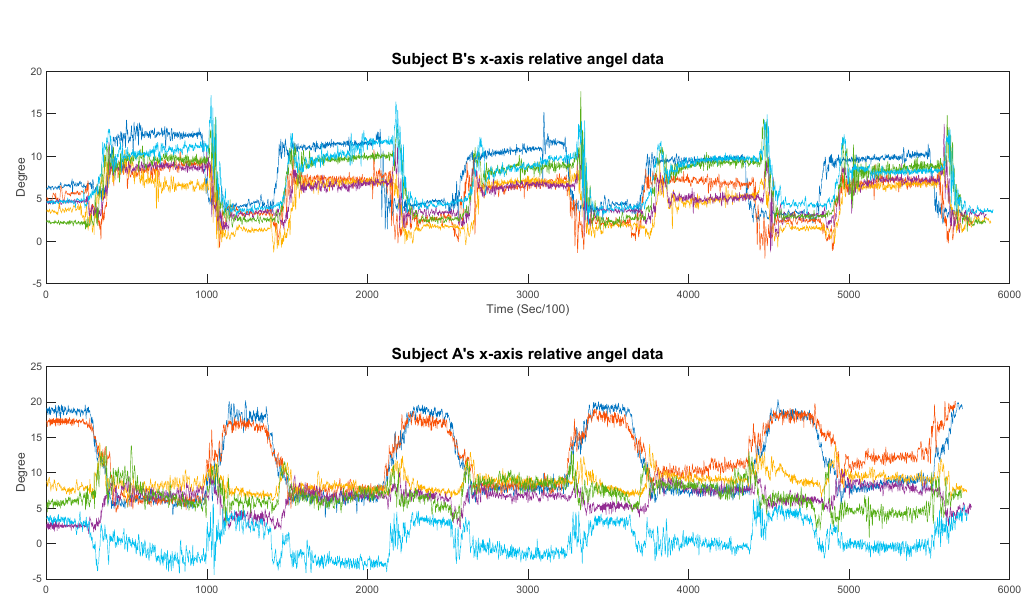
Figure A2. Variation of Ex.3 ′ s original motion angles in x-axis for subjects A and B. Subject A’s postures were unstable in comparison with Subject B when playing the motions. Subject A adjusted the motion postures later, and then resubmitted the correct measurement data for improving the analysis.